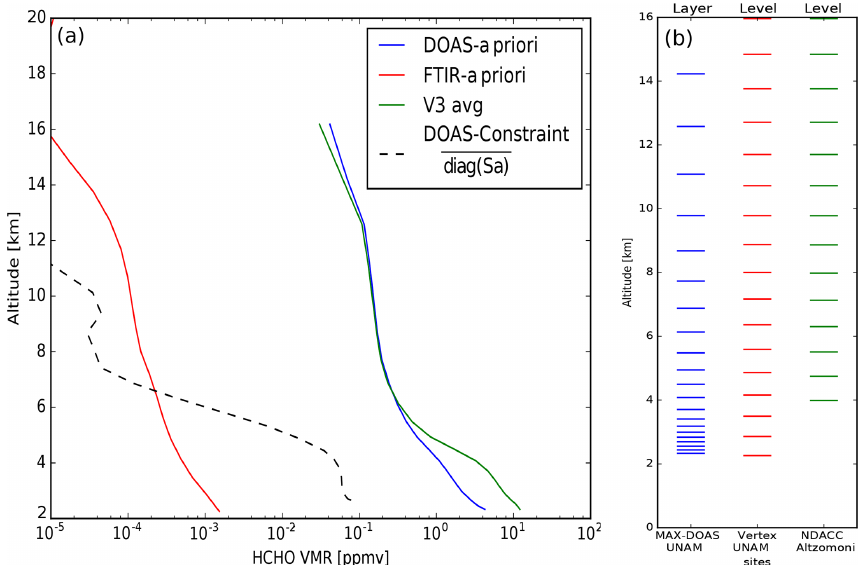
Figure 6. (a) A priori information for the MAX-DOAS and FTIR retrievals. The blue line is the a priori information used in the MAX-DOAS retrieval; the black dashed line shows the square root of the Sa matrix in the MAX-DOAS retrieval regularized according to optimal estimation (OE). As commonly used for FTIR retrievals that form part of the NDACC network, a priori information taken from the WACCAM model was used. The green line is the average of the MAX-DOAS instrument retrieved HCHO profiles (V3, both sides) and gives an idea about the vertical distribution of HCHO above UNAM. This averaged profile is used as common a priori information for the improved intercomparison between MAX-DOAS and FTIR instruments. (b) Vertical grids of the MAX-DOAS and FTIR (both measurement sites) inversions. Diagonal: